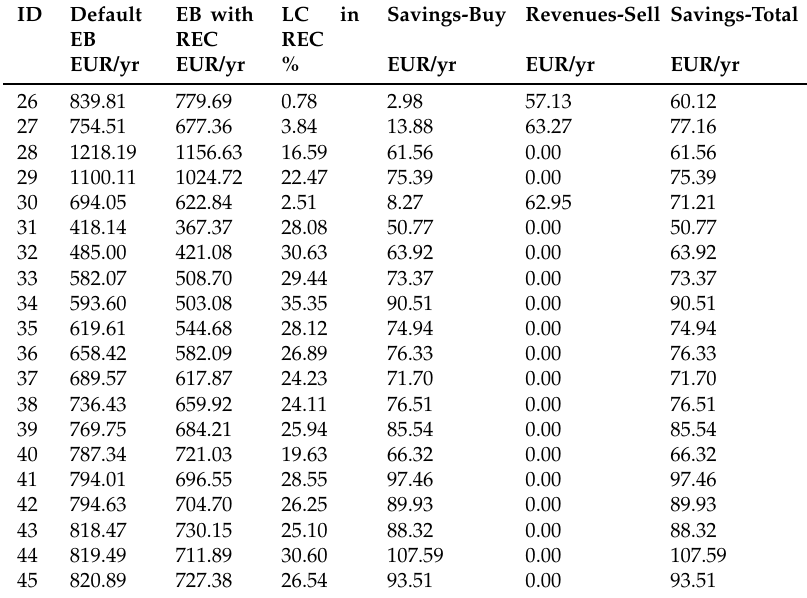
Table 7. Purely residential REC: Results for customers 26–45. Detailed explanation of the individual columns given in Table 5. Note, that revenues due to selling electricity within the community are zero for MAB residents 31–45 despite the availability of an in-house PV system, because the PV system is